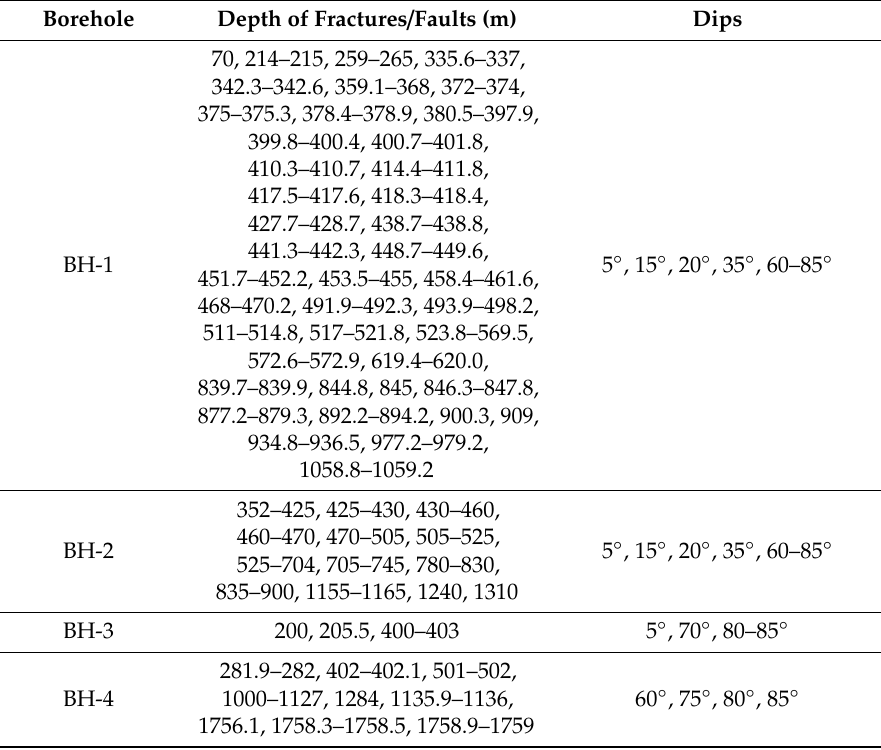
Table A2. Depths and dips of the fractures / faults at the boreholes.